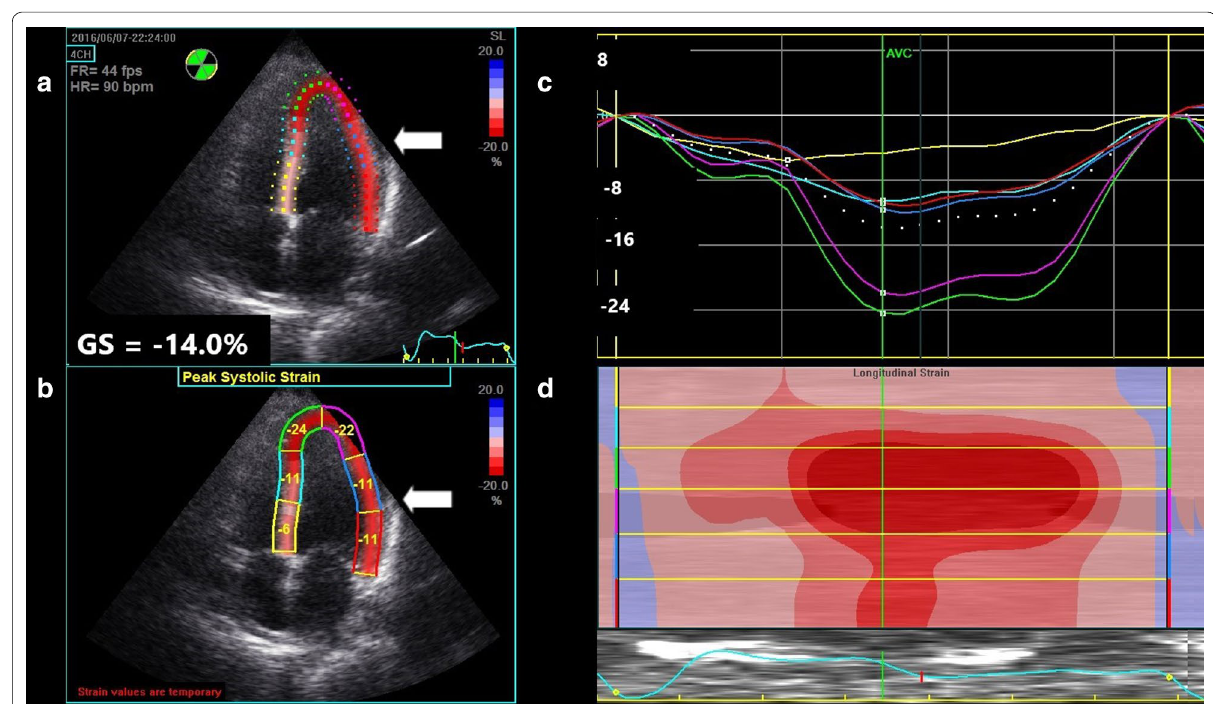
Fig. 2 Quad display of peak longitudinal strain of patient after